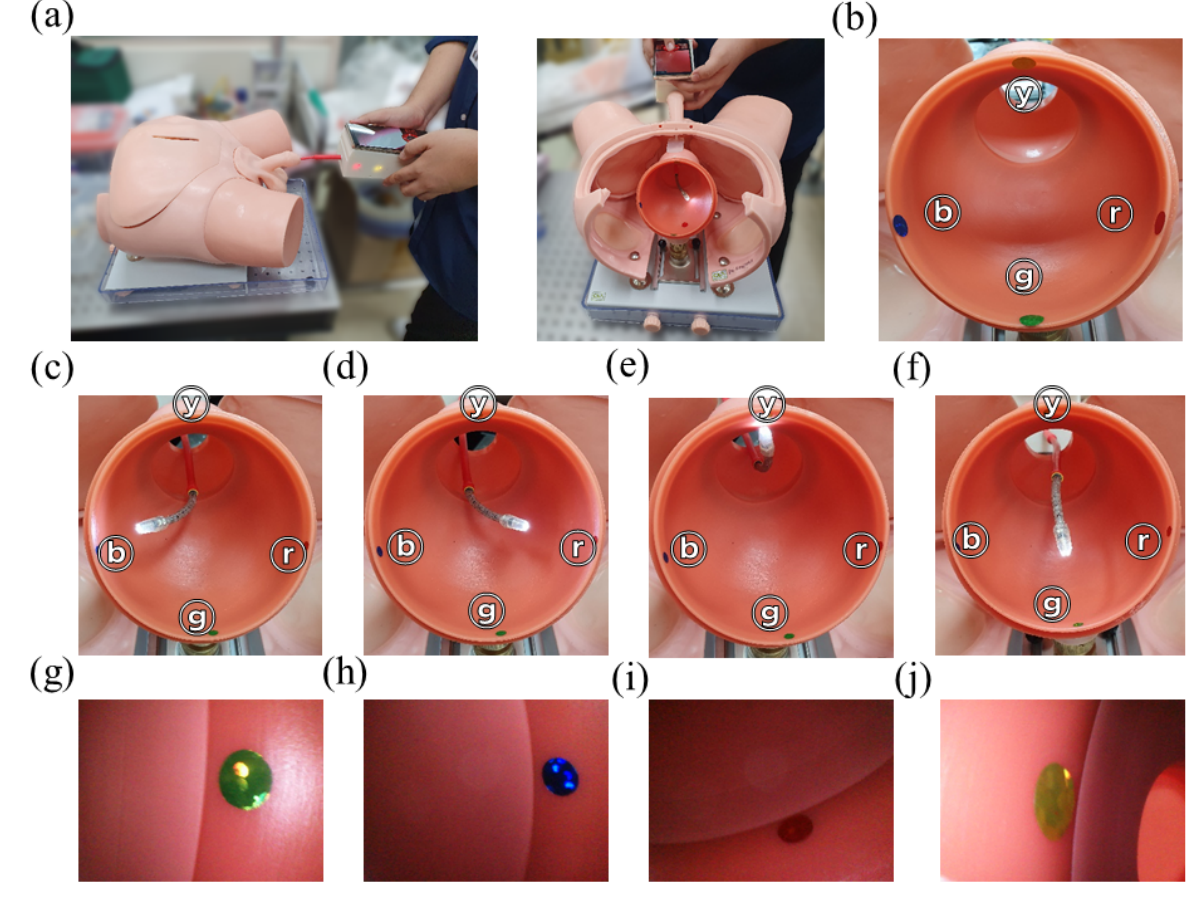
Figure 14. Articulation experiment on the bladder phantom: (a) endoscope experiment in operation, (b) placement of stickers on the inner side of the phantom (upper side, yellow ⓨ ; on the left, blue ⓑ ; on the right, red ⓡ ; on the lower side, green ⓖ sticker, which was attached as an index), (c-f) articulation in four directions, and (g-j) corresponding images of the stickers obtained using the homebuilt smartphone